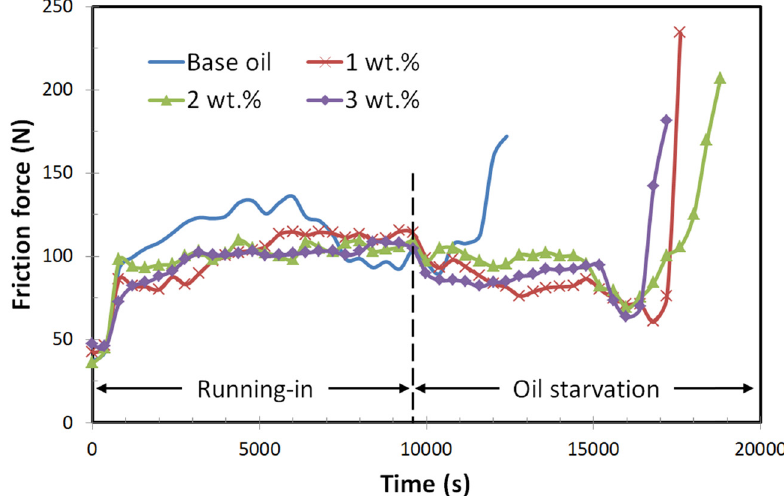
Figure 10: The typical friction force variation of the nitriding liner and the PVD - CrN piston ring in scu ffi ng tests lubricated with di ff erent PANi/ND